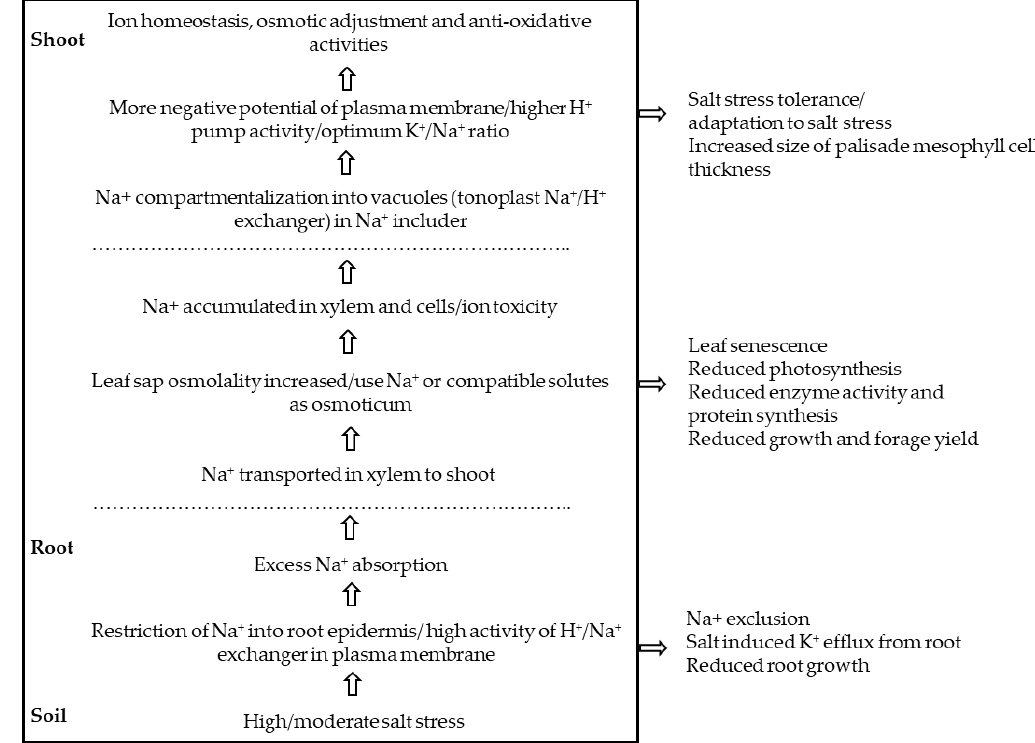
Figure 2. Summary of salt stress tolerance in alfalfa.